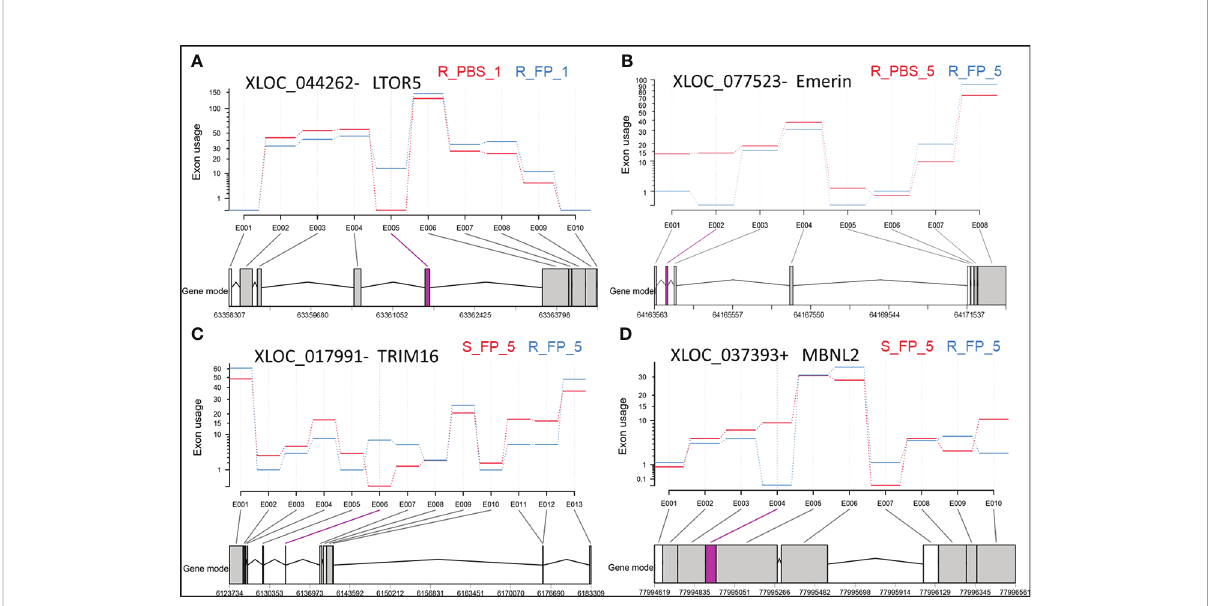
FIGURE 5 Exonic regions showing differential usage in antisense transcripts overlapping with LTOR5 (A) , Emerin (B) , TRIM16 (C) , and MBNL2 (D) . Signi fi cant differentially used exons (DUEs) are represented in pink at the bottom of each panel. Each biological condition is represented by the genetic line (R or S), type of injection (FP or PBS), and days post-injection (day 1 or day